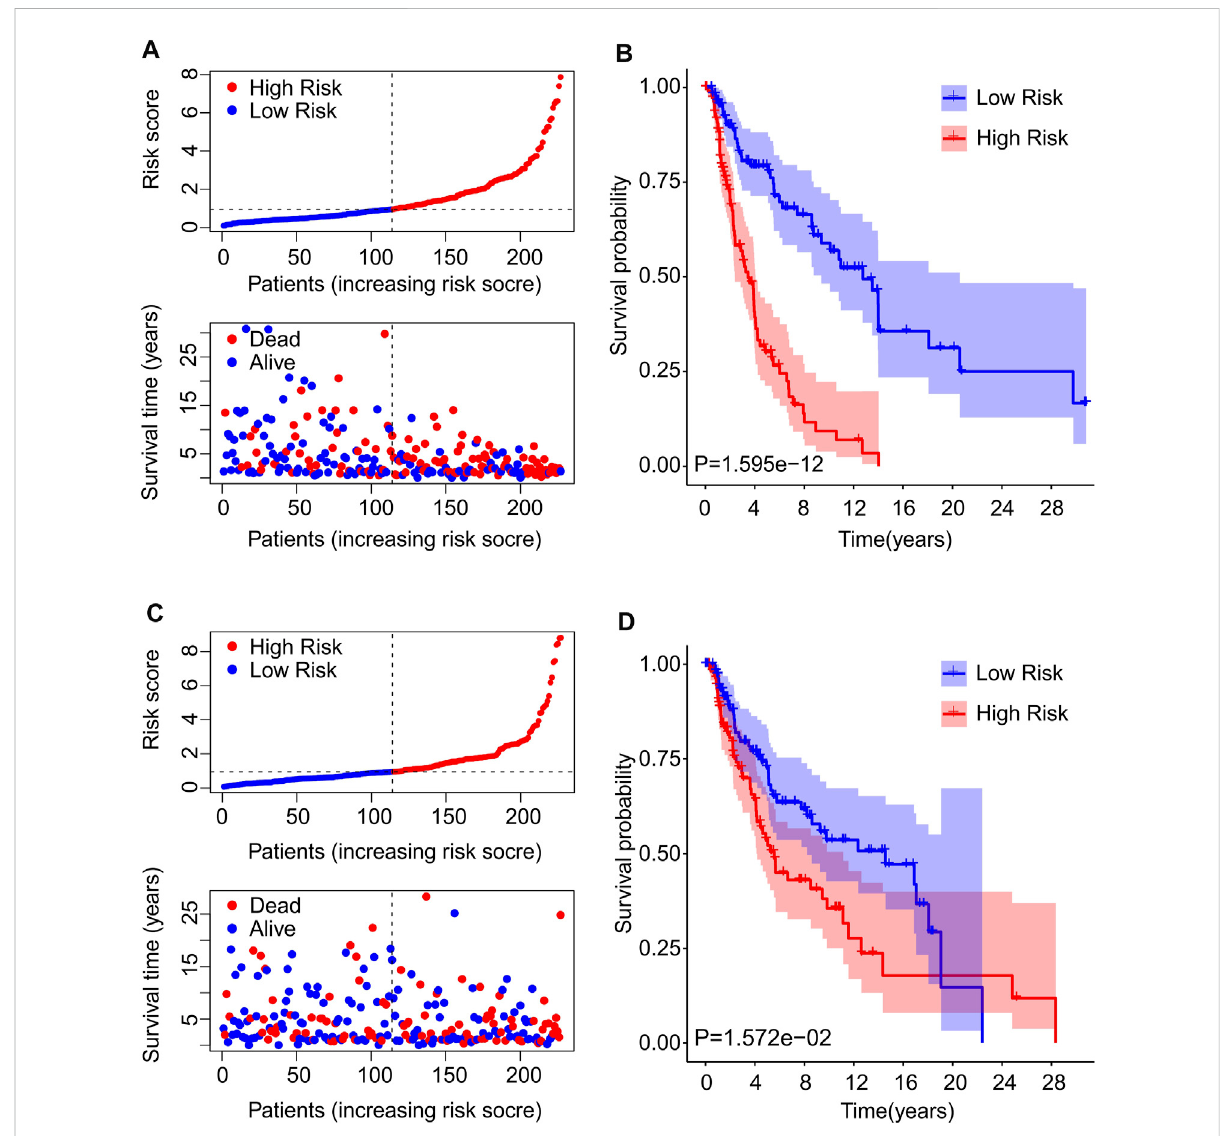
FIGURE 5 Riskmodelconstructionoftraining cohortandvalidation cohort. (A) The distribution ofriskscores andscatter dotplotofCMpatients basedon the cuproptosis-related lncRNAs prognostic signature in the training cohort. (B) The Kaplan-Meier survival curve displayed that the overall survival rate of patients with high-risk scores was signi fi cantly shorter that those with low-risk scores in thetraining cohort. (C) The distributionof riskscores and scatter dot plot of CM patients based on the cuproptosis-related lncRNAs prognostic signature in the validation cohort. (D) The Kaplan- Meiersurvivalcurveshowed thattheoverallsurvivalrateofpatients withhigh-riskscoresissigni fi cantly shorterthatthosewith low-riskscores inthe validation